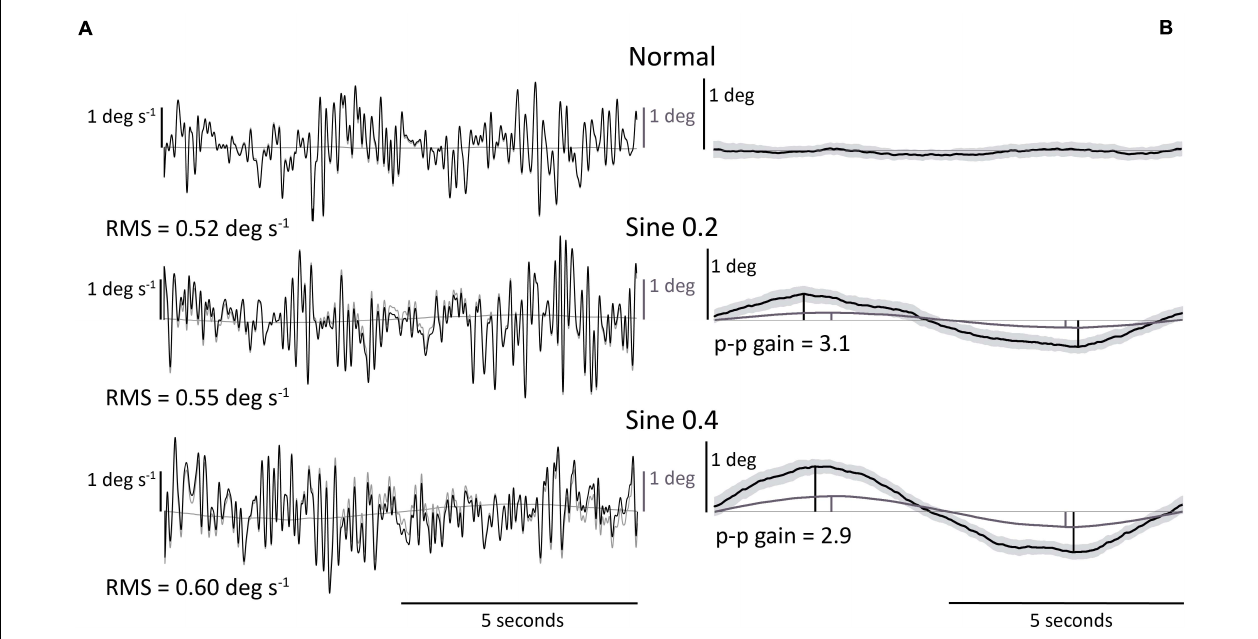
FIGURE 1 | Illustrative representative dataset. (A) RMS body angular velocity. Section of body angular velocity from one participant in 3 conditions, with (black) or without (gray) 0.05–0.15 Hz notch Butterworth filter. Footplate angle (gray) is added for reference. (B) Body angle p-p gain (ratio of body to footplate angle). Average body angle from one participant in 3 conditions. Light gray area shows 95% confidence interval of data averaged across 30 trials. Footplate angle (gray) is added for reference. Body angle p-p gain was only calculated in disturbed conditions.